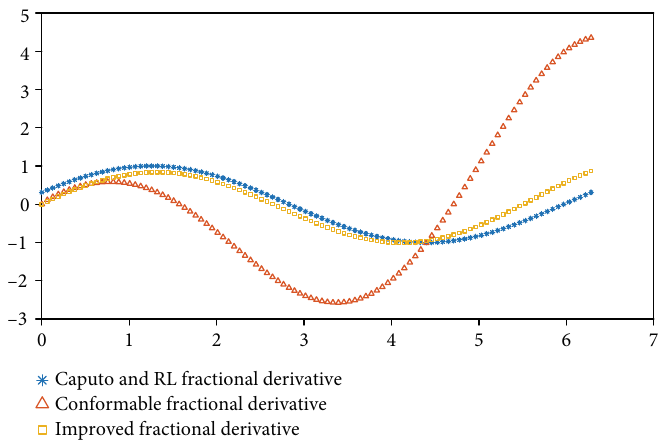
Figure 6: 0.2th fractional derivative of y = sin x